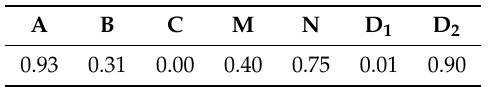
Table 2. JH ‐ 2 calibrated material properties values for gres.